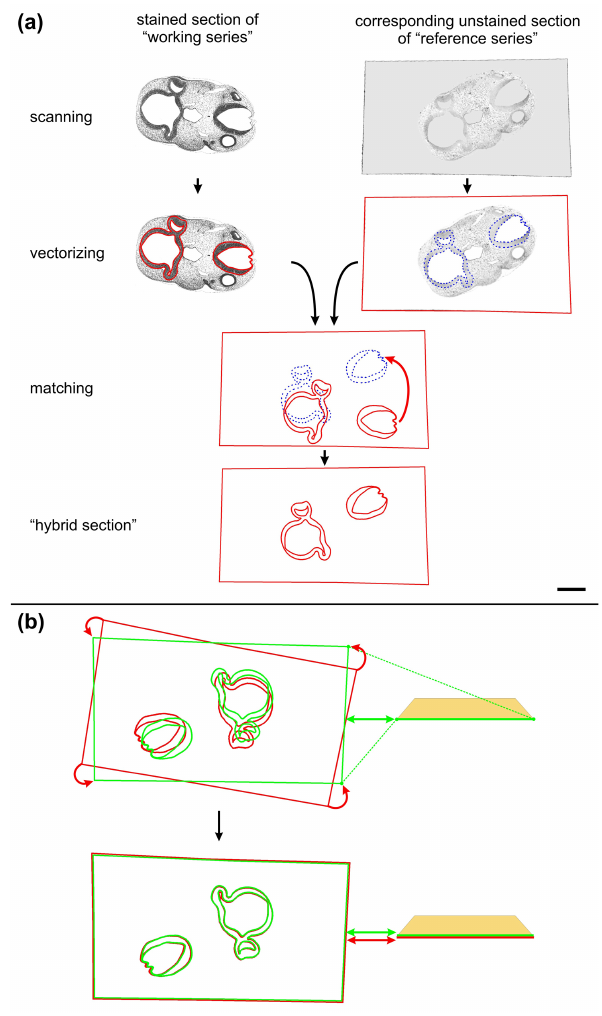
Figure 15. Realignment of histological serial sections with the help of external fiducials to build up 3-D reconstructions of apoptotic cells in the nervous system of Tupaia belangeri . (a) Semithin sec- tions (1µm) of a 15-day-old Tupaia embryo were alternately placed on two sets of slides. Sections from the “working series” stained with hematoxylin (Heidenhain) were scanned at high resolution ( × 100 objective lens, “Huge Image”) and were used for vectoriza- tion of apoptotic bodies (not shown) and contours of the develop- ing brain (red contours). Adjacent unstained sections from the “ref- erence series” were scanned at low resolution ( × 5 objective lens) and were used for vectorization of the contours of the embedding block (red block contours). The vectorized embryonic contours are matched to the unstained section (dashed blue lines) and are then fused with the block contours to create a “hybrid section”. (b) Hy- brid sections are realigned with the help of the contours of the em- bedding block. The lower hybrid section (red) is matched to the upper one (green). Right side of the scheme: positions of the two hybrid sections in the pyramid-shaped stack of realigned hybrid sections. Scale bar = 500µm. Reprinted from Knabe et al. (2002, Figs. 2, 3a). © 2002, with permission from Elsevier.